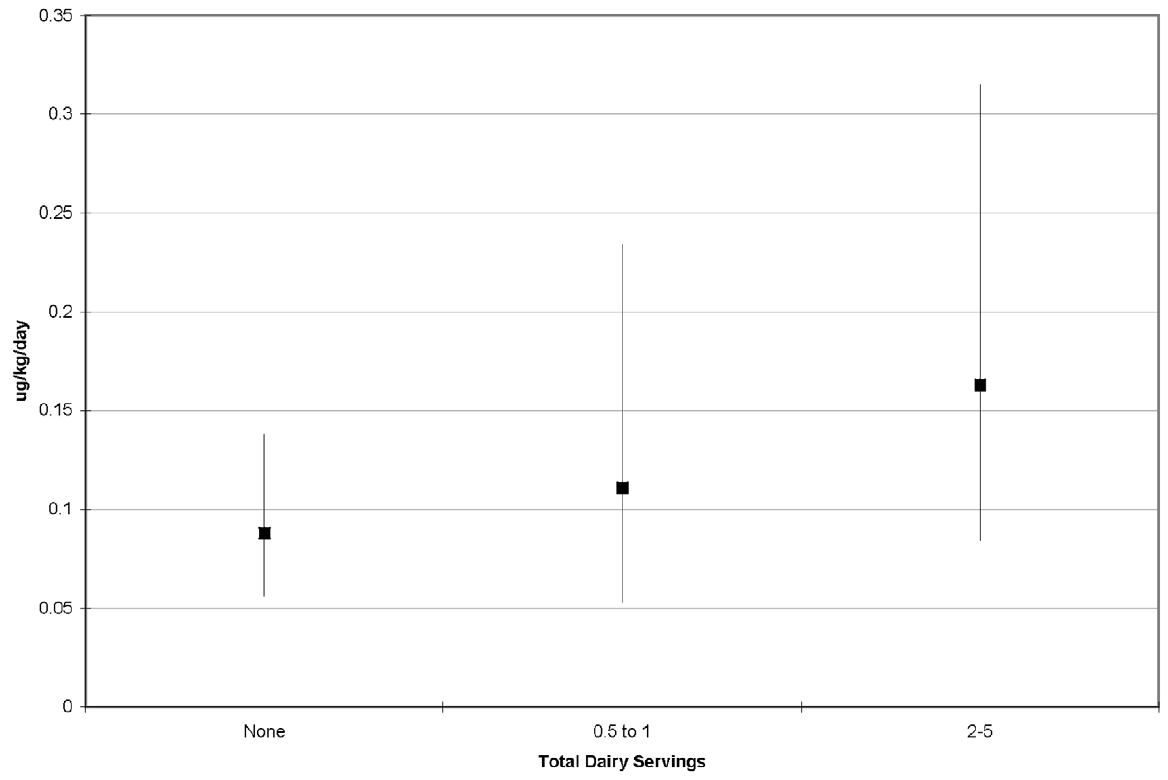
Figure 2. Geometric mean perchlorate dose in urine ( m g/kg of body weight/day) and 95% confidence intervals in study participants by total dairy servings, Imperial County, California, 2009.